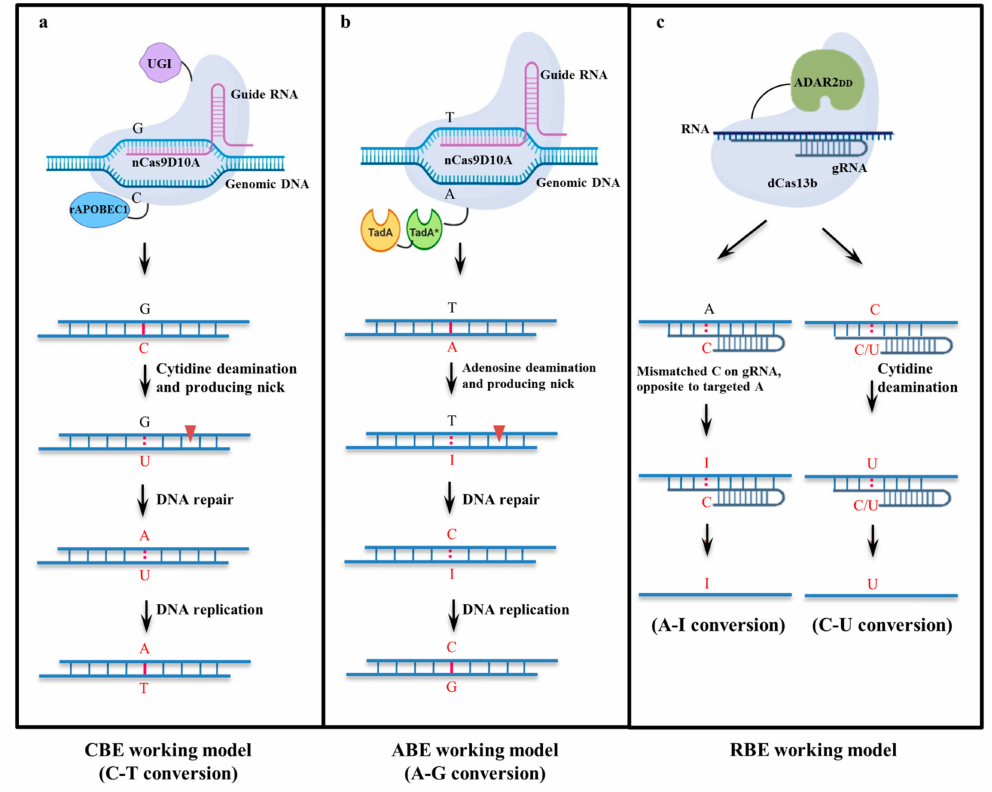
Figure 2. Base editing mechanisms. ( a ) Cytosine base editor: C to T base editing strategy; ( b ) Adenine base editor: A to G base editing strategy; ( c ) RNA base editing mechanisms: A to I (left) and C to U (right) RNA base editing strategies. Abbreviations: UGI, uracil glycosylase inhibitor; rAPOBEC1,